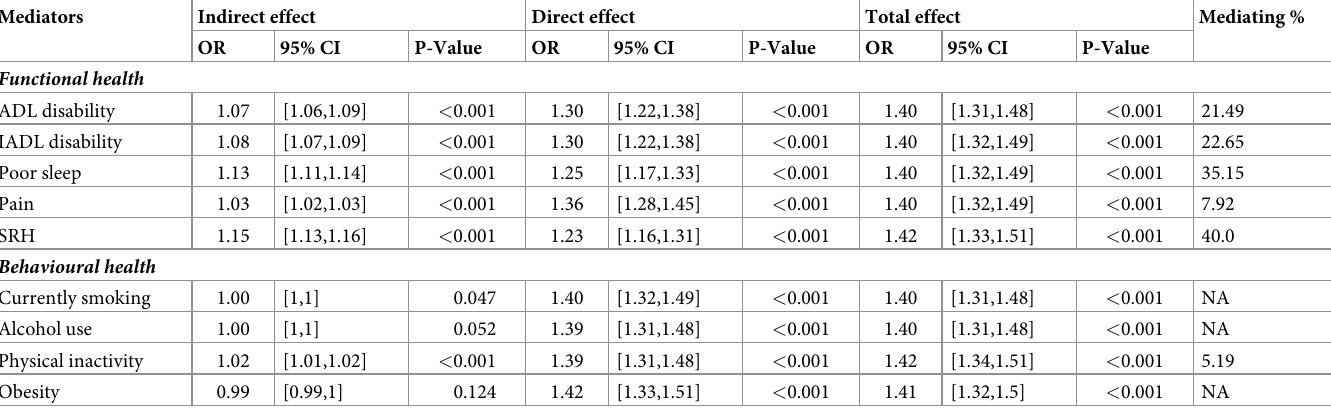
Table 3. Functional and behavioural mediators in the association between multimorbidity and depression (based on total sample). Mediators